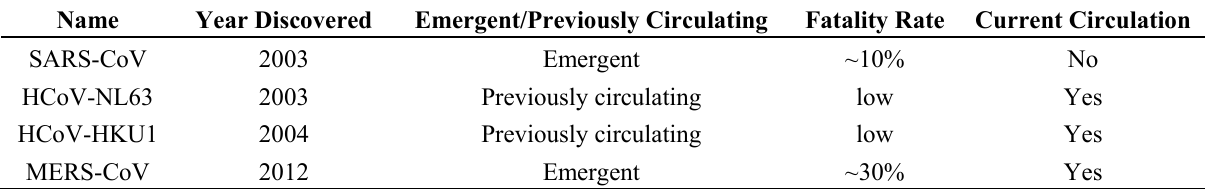
Table 1. Human coronaviruses identified since